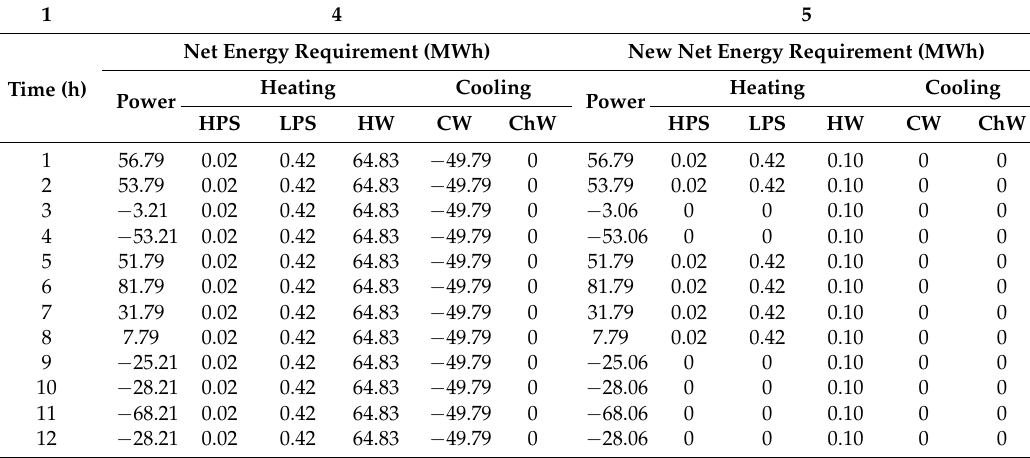
Table A11. TriGenSCA after iteration from 1 to 12